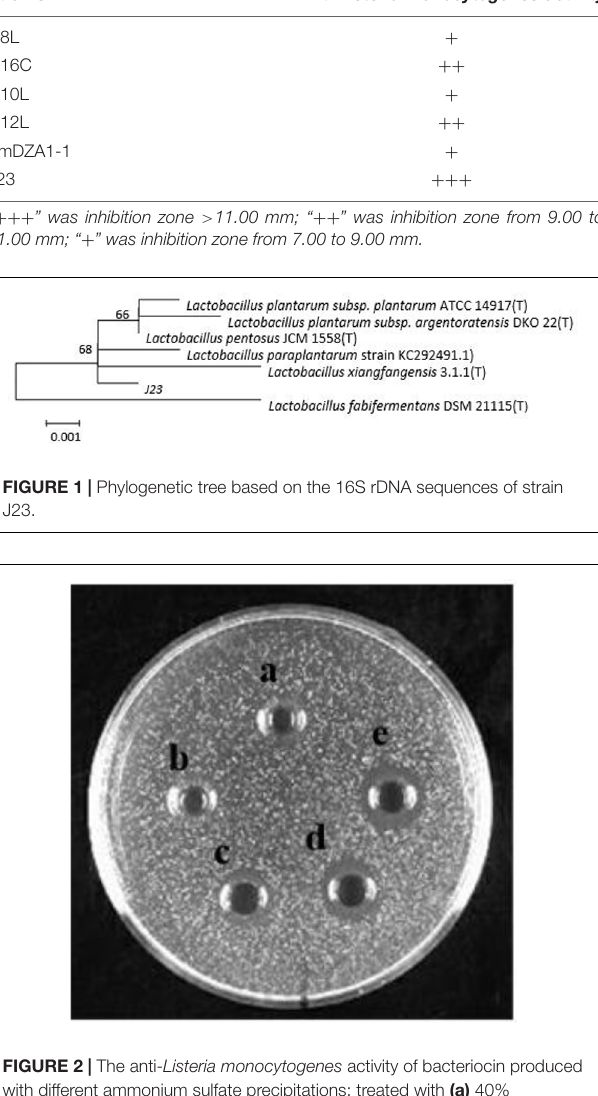
FIGURE 2 | The anti- Listeria monocytogenes activity of bacteriocin produced with different ammonium sulfate precipitations: treated with (a)